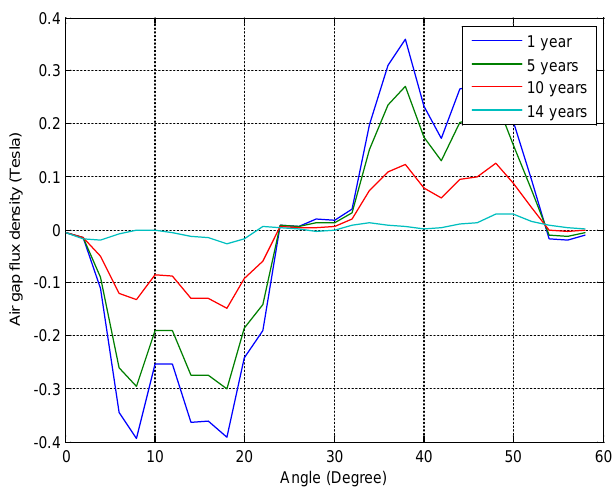
Figure 25. The change in air gap flux density with magnet aging (150 °C).